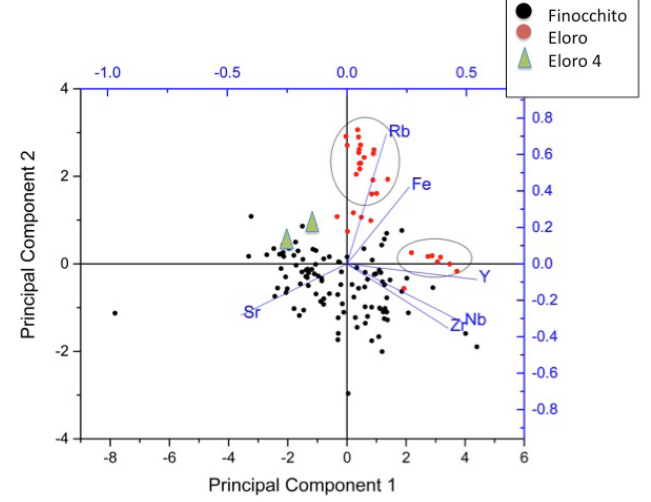
Figure 3. Scatterplot with Eloro